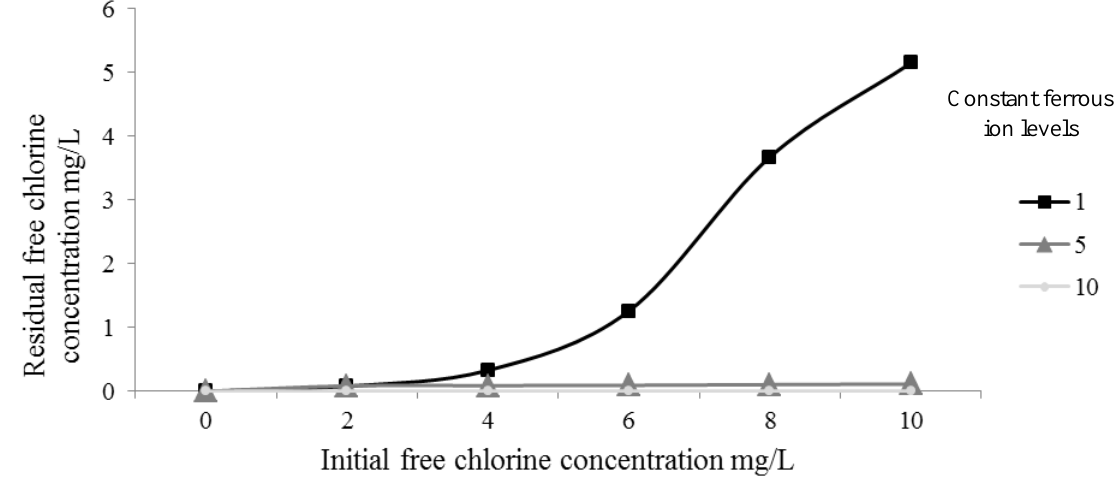
Figure 1: Residual free chlorine levels at constant initial ferrous ion concentrations of 1, 5 and 10 mg/L.